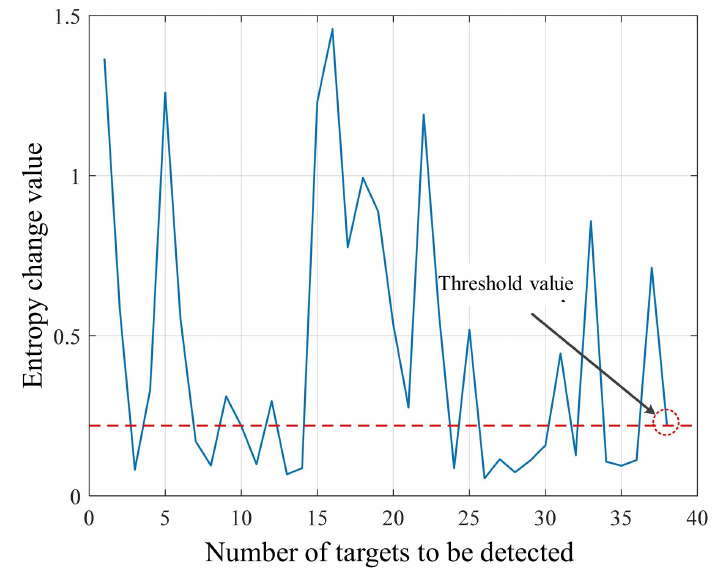
Figure 18. Entropy change rate result.